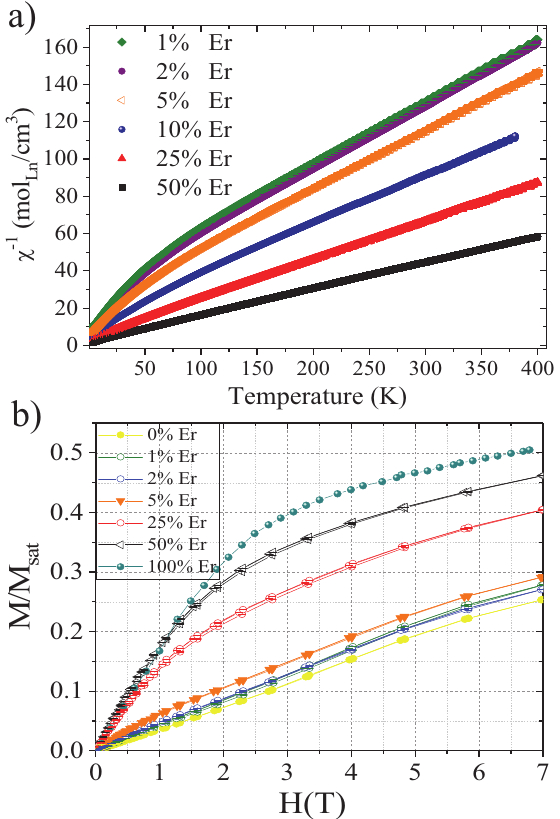
Figure 5. ( a ) DC inverse magnetic susceptibility as a function of temperature for an external magnetic field of H = 1T for all powder samples. ( b ) Magnetic moment as a function of the external magnetic field at 2K. Data for SrYb 2 O 4 and SrEr 2 O 4 are from [14] and [7],